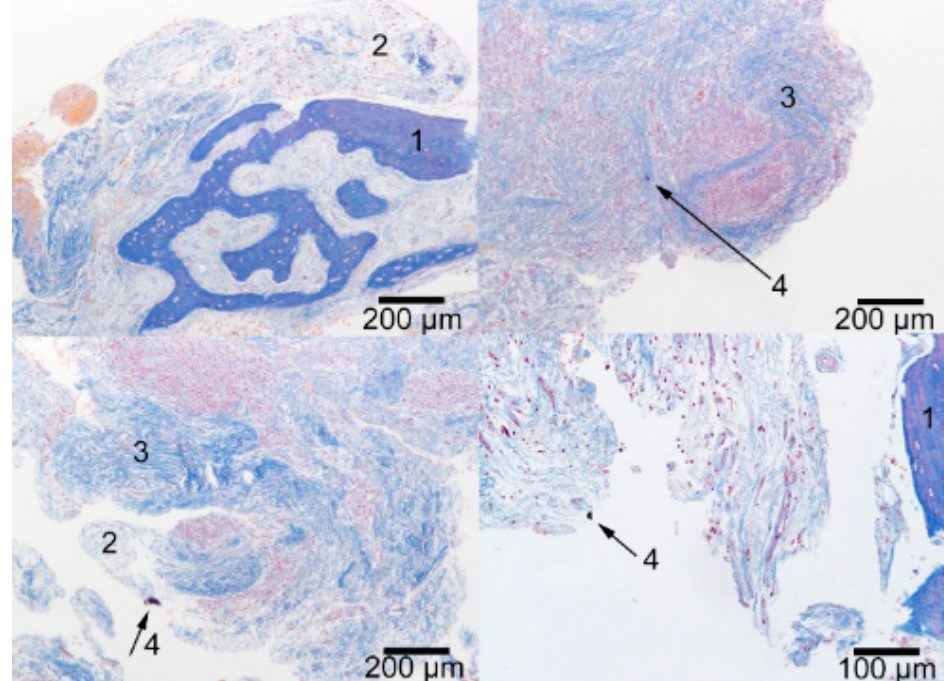
Figure 5. Results of histological study of biopsy specimens from the patient’s bone bed (Mallory staining): (1) Bone tissue; (2) Granulation tissue at different stages of maturation; (3) Maturing dense fibrous connective tissue; (4) Foreign particles.